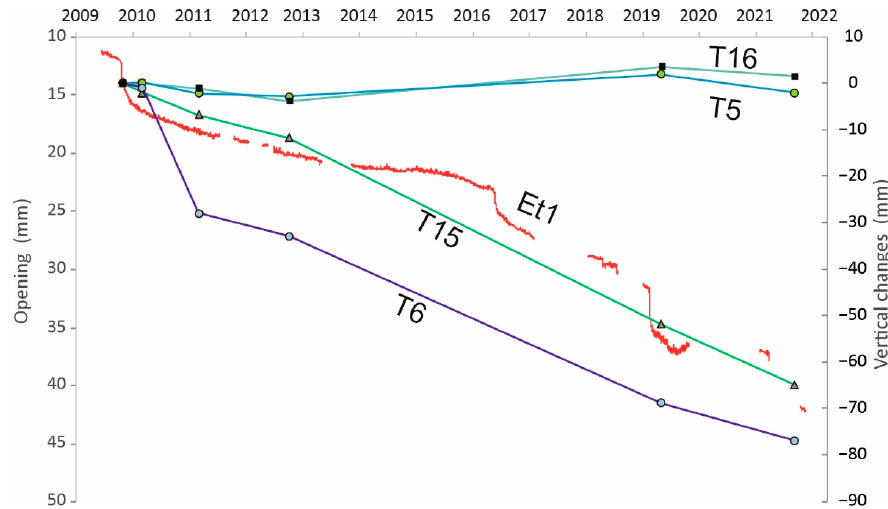
Figure 11. Time series of vertical changes at the benchmarks crossing the TF (T5–T6 in southern side and T15–T16 in northern side) compared with 2009–2021 extensometer data (ET1).